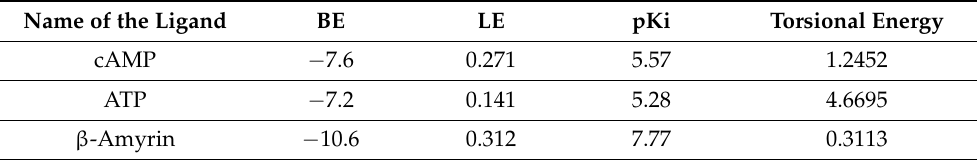
Table 5. Docking hits and their binding affinities toward Rv1636 protein.